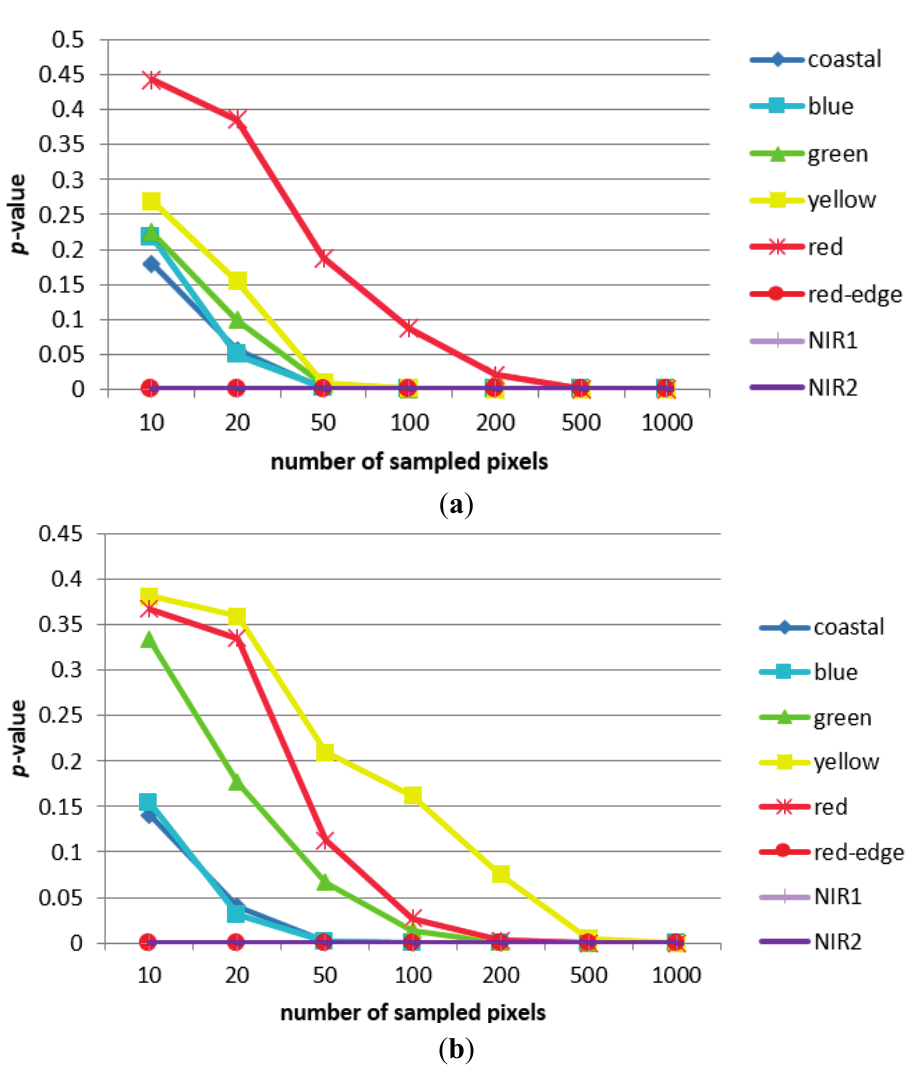
Figure 6. The per-band p -value computation between segments with different land covers (a black roof and a grass patch) when different sizes of sampled pixel sets were applied and when: ( a ) the two-sample Kolmogorov-Smirnov statistics; ( b ) the Student’s t -test statistics was